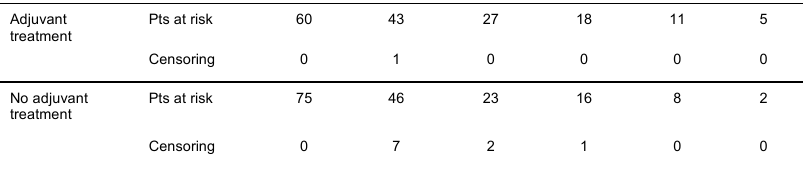
Figure 2. Nodal or metastatic recurrence-free survival rates in patients with tumors invading the muscularis mucosae (pT1a-m3) or the submucosa (pT1b-Sm) with and without adjuvant chemoradiotherapy and/or surgery.